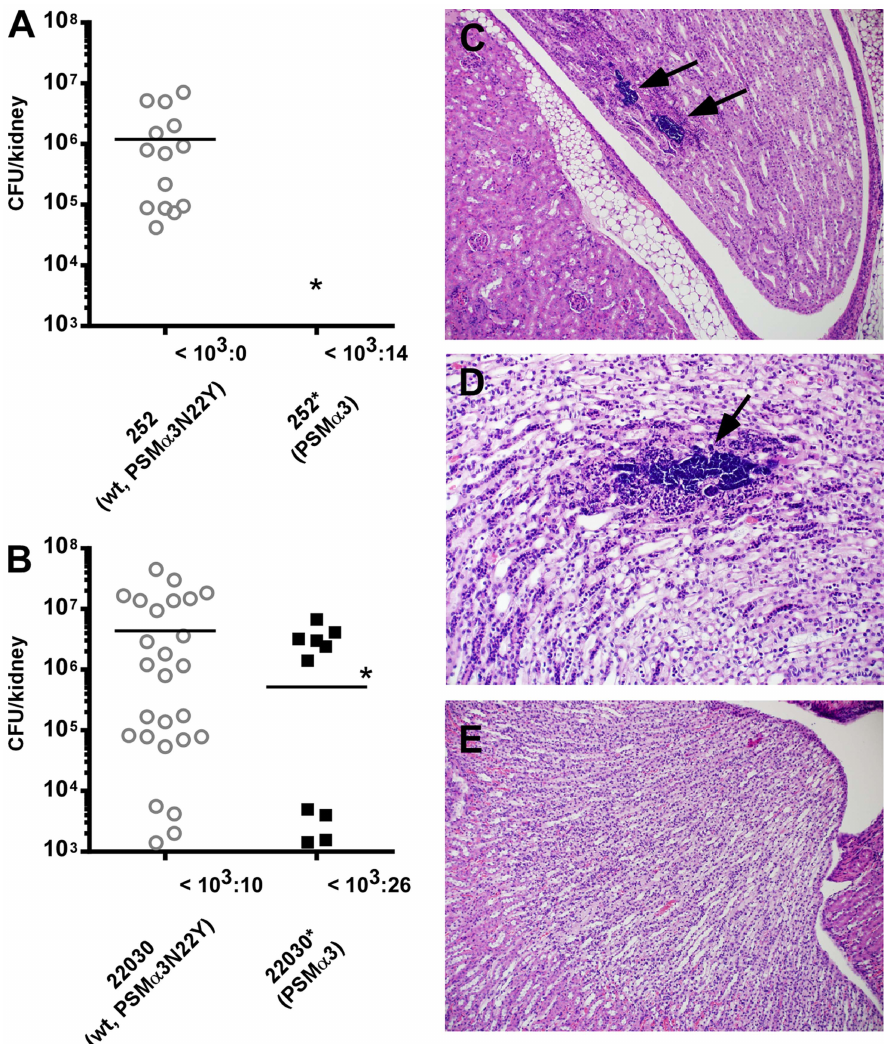
Figure 6. The PSM a 3 variation significantly impacts virulence of CC30 MRSA in experimental blood infection. (A) The MRSA252 strain (252, expressing PSM a 3N22Y) was compared to a strain (252*) in which the psm a 3 gene was changed to express non-CC30 PSM a 3 in a mouse model of blood infection. Hematogenous seeding into the kidneys was measured 4 days after infecting mice via the tail vein with 1 6 10 7 CFU. Results from kidneys with considerable bacterial numbers ( . 10 3 CFU) are shown in the graph; the number of kidneys with lower or no bacteria is shown at the bottom. Analysis of significance was performed with the numbers obtained from all kidneys; *, p , 0.05. Number of mice used per strain: 10. Two counts per analyzed kidney were performed. (B) Experiment as in (A) with strain 22030 expressing PSM a 3N22Y and the isogenic 22030* strain expressing PSM a 3. Number of mice used per strain: 20; two counts per analyzed kidney are included; inoculum: 1 6 10 6 . *, p , 0.05. (C, D) Tubulointerstitial nephritis with large colonies of bacteria (arrows) in kidneys infected with strain 252, magnification 100 6 (C) and 200 6 (D). (E) Absence of signs of infection in kidneys infected with strain 252* (magnification 100 6 ).